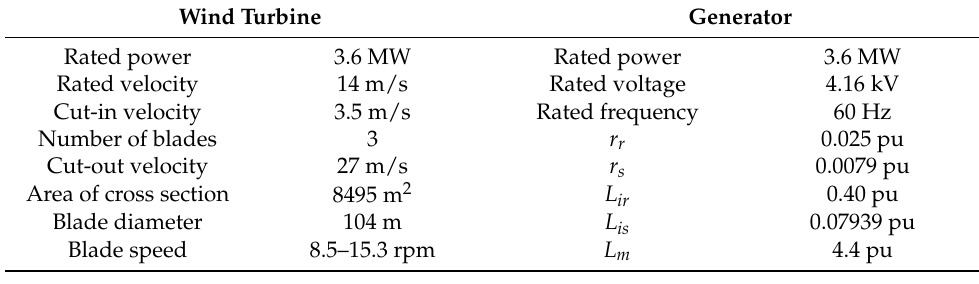
Table 3. Parameters of a DFIG system.